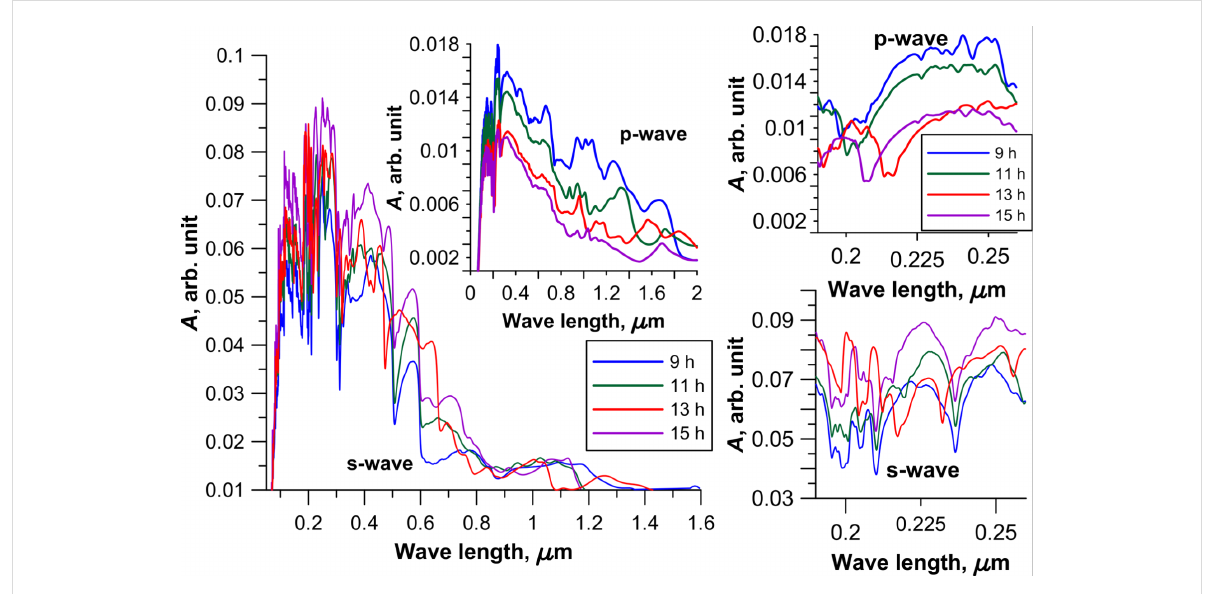
Figure 6: The absorption coefficient of 2D CNT-graphene hybrid nanocomposite with the same tube (18,0) and different intertube distances. The insets on the right side show the absorption coefficient for the wavelength range of 190–260 nm.